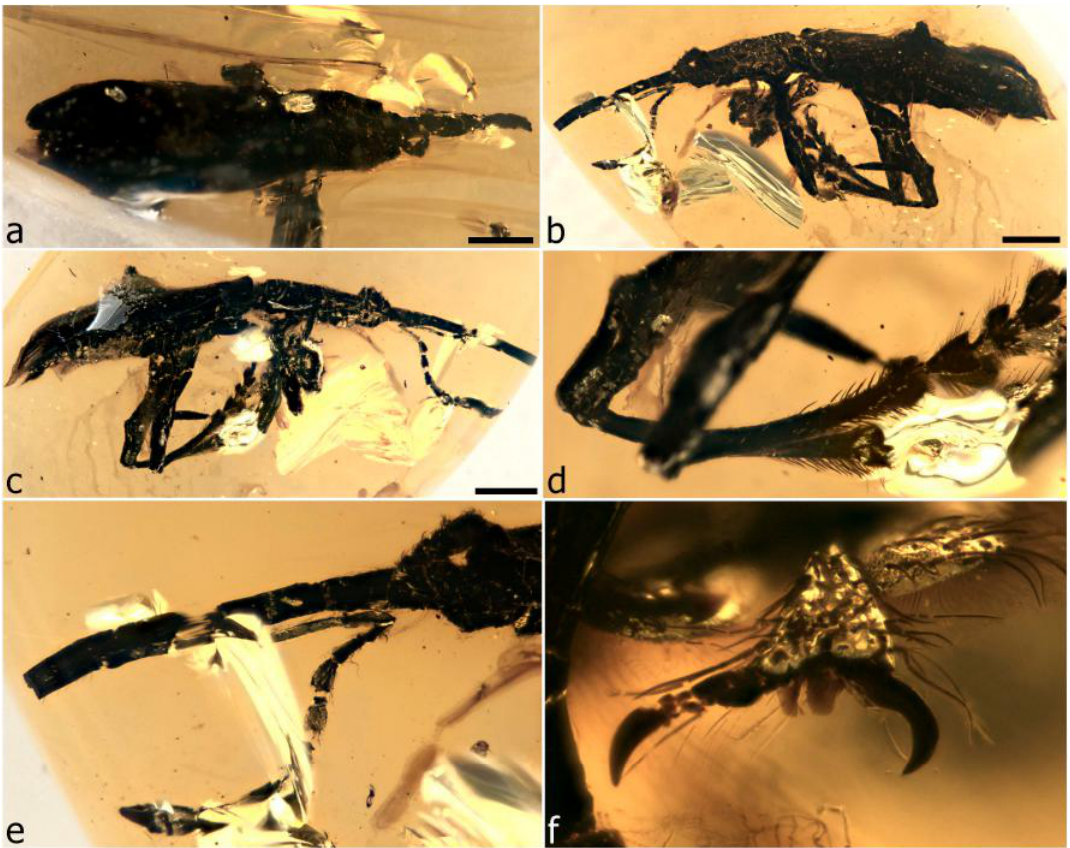
Figure 34. Burmocorynus longus sp. n., holotype. Habitus, dorsal ( a ); habitus, left lateral ( b ); habitus, right lateral ( c ); right metatibia and tarsites 1–3, showing pair of short spurs between coarse short rows of inner and outer apical fringing setae ( d ); head and left antenna, left lateral ( e ); left protibial claws, showing lobate ventral apex of claw segment (artefact) ( f ). Scale bars: 1 mm ( a – c ). Genus Petalotarsus Clarke & Oberprieler, gen. n.